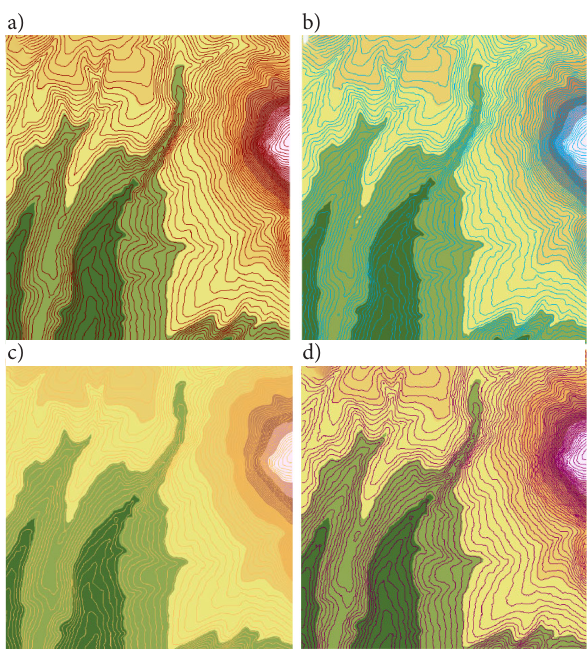
Australia.Figure 8. DEM generation with contours based on 10908